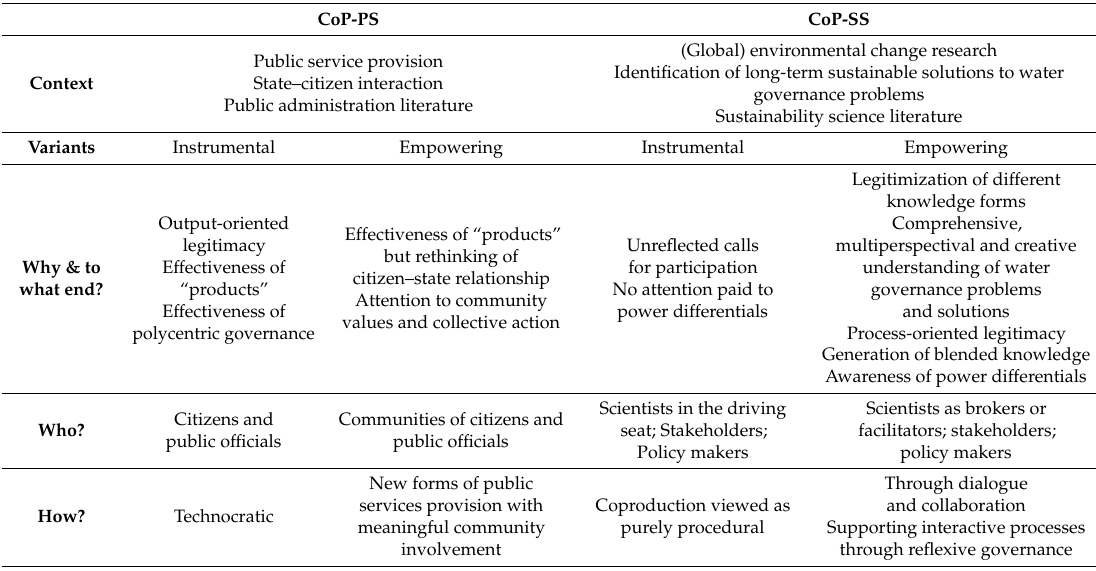
Table 1. The main implications and differences of two main traditions of coproduction in the water governance literature. CoP-PS: the public services view; CoP-SS: the sustainability science view. CoP-PS